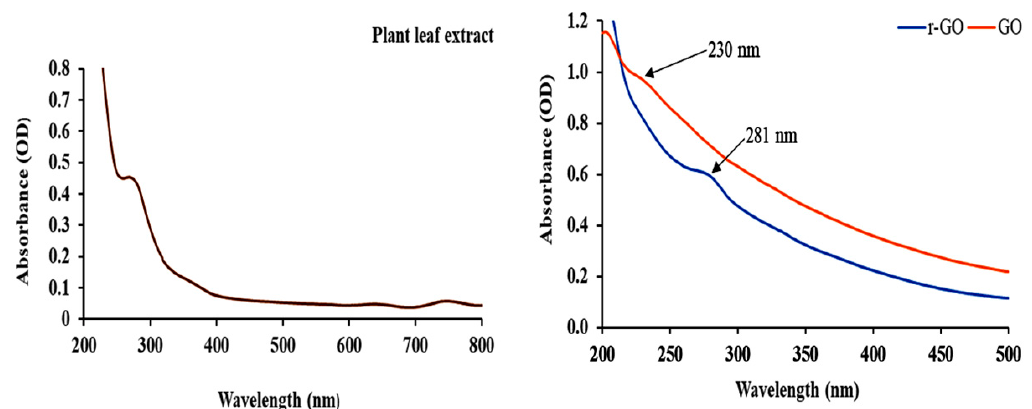
Figure 4. UV–Vis absorbance peak optical density (OD) vs. wavelength (nm).